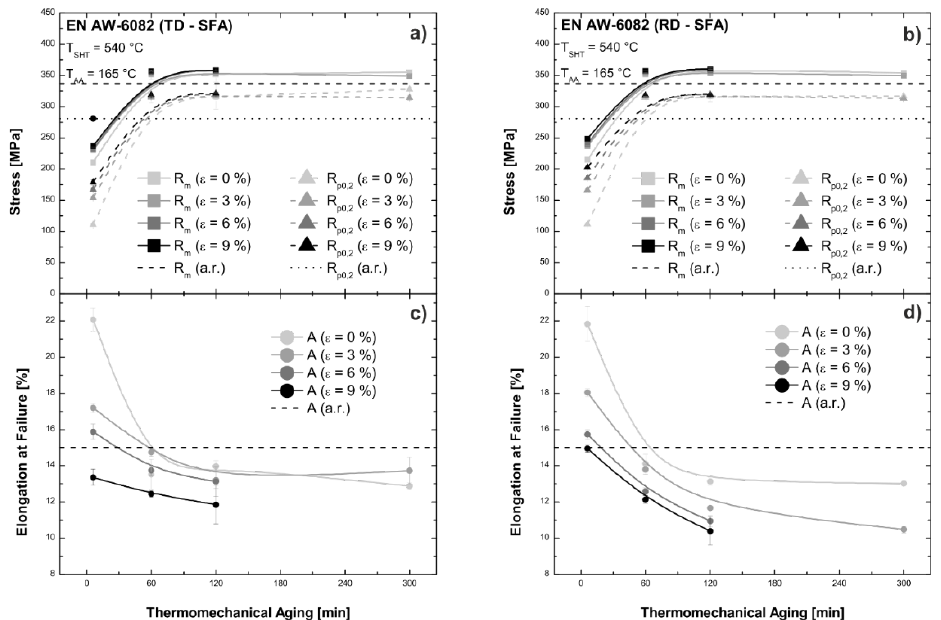
Figure 3. Influence of aging duration and strain on mechanical properties of AA6082 for thermo- mechanical aging strategy “ Simultaneous Forming and Aging ” ( a ) and ( c ) transverse and ( b ) and ( d ) parallel to the rolling direction. All specimens are taken from the thermo-mechanically aged conditions and are tested at room temperature.